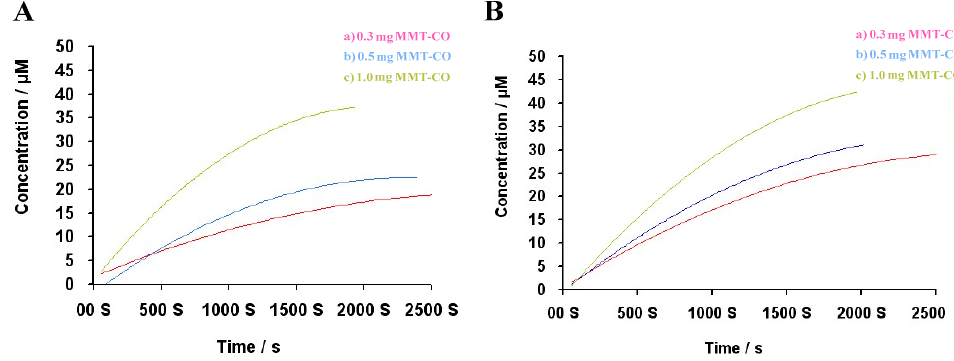
Figure 9. The kinetic release profile Ru@MMT-1 ( A ) and Ru@MMT-2 ( B ).